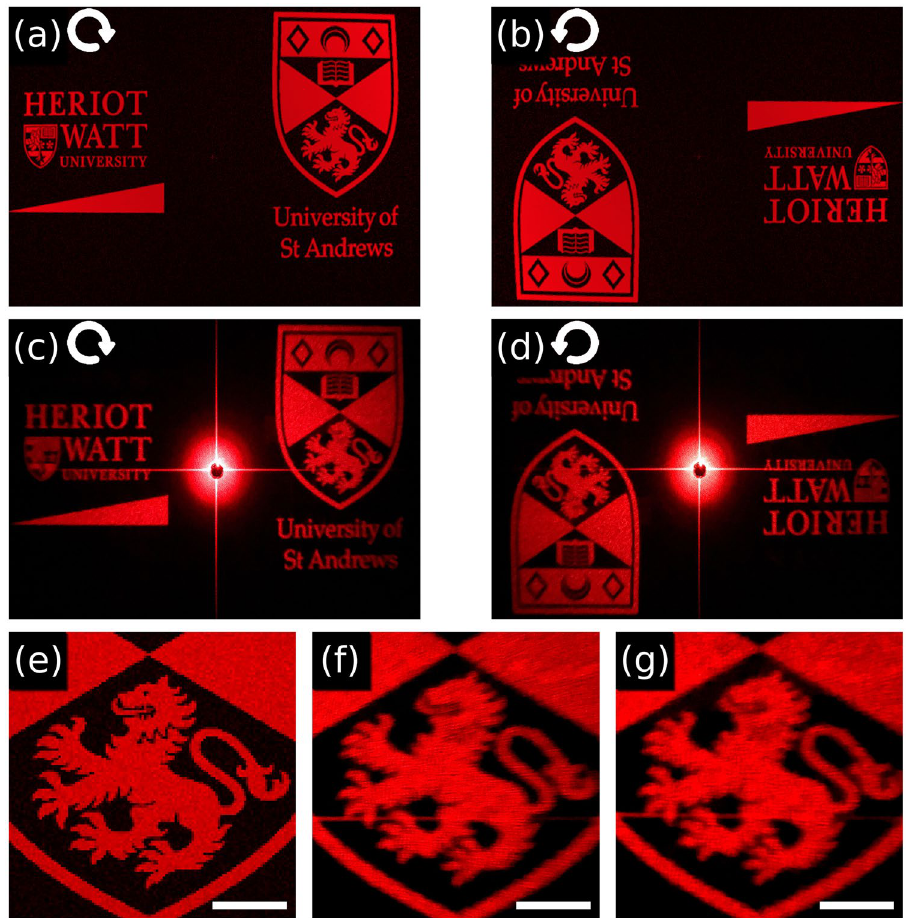
Figure 4. Reconstructed images for the incident light with a wavelength of 650 nm at normal incidence. The simulation results for the incident light with ( a ) right circular polarization and ( b ) left circular polarization and the corresponding experimental results after lift-off shown in ( c ) and ( d ). ( e ) Simulated close up of the lion. The comparison of experimentally measured close up of the lion ( f ) before and ( g ) after lift-off from the substrate. The scale bar is 10 mm with a MS to screen spacing of 100 mm. The University of St Andrews logo is © University of St Andrews and used with permission. The Heriot-Watt logo is © Heriot-Watt University and used with